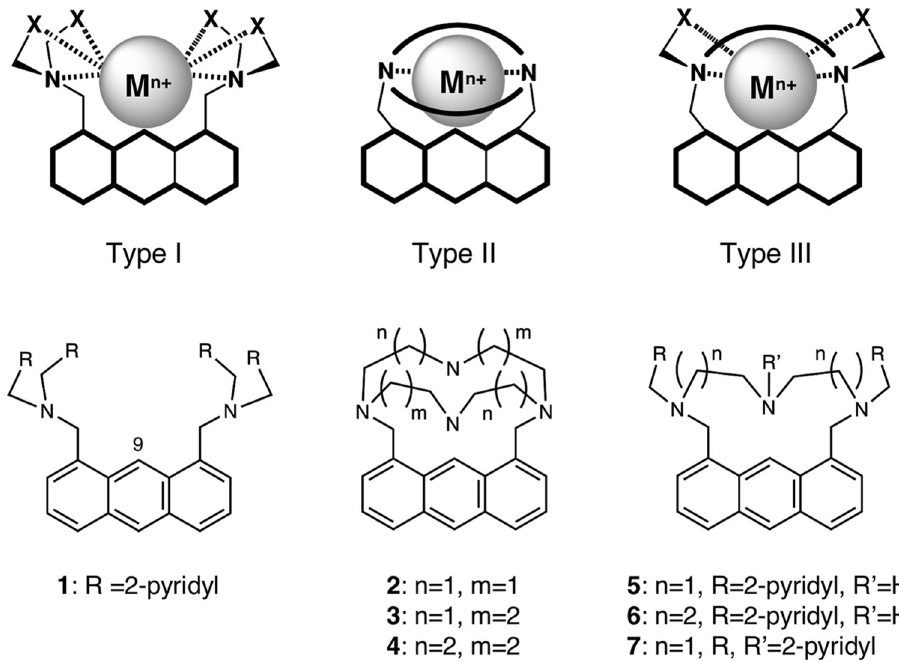
Fig. 1 Design of AM-contact probe. General designs (upper) and structures (lower) of tricyclic fl uorescent probes for metal ion sensing based on arene – metal-ion contact (AM-contact).